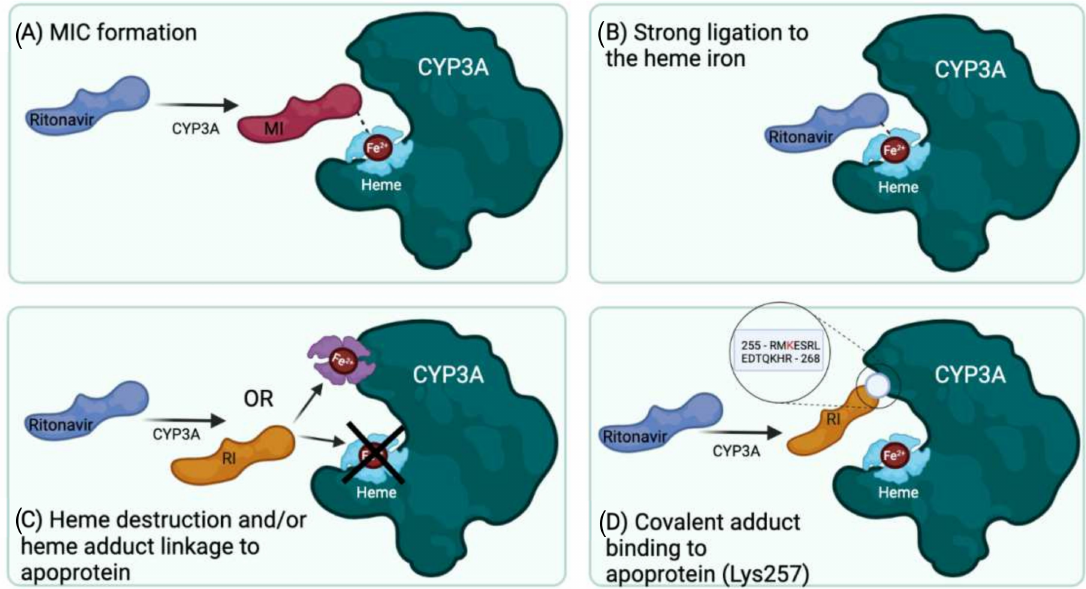
Figure 6. Highly schematic overview of the four main mechanisms of inactivation of CYP3A4/5 by ritonavir proposed in the reviewed studies. For simplicity, CYP3A is depicted here in a wide-open static configuration and no attempt was made to mimic real 3D structures. MI, metabolic intermediate; RI, reactive